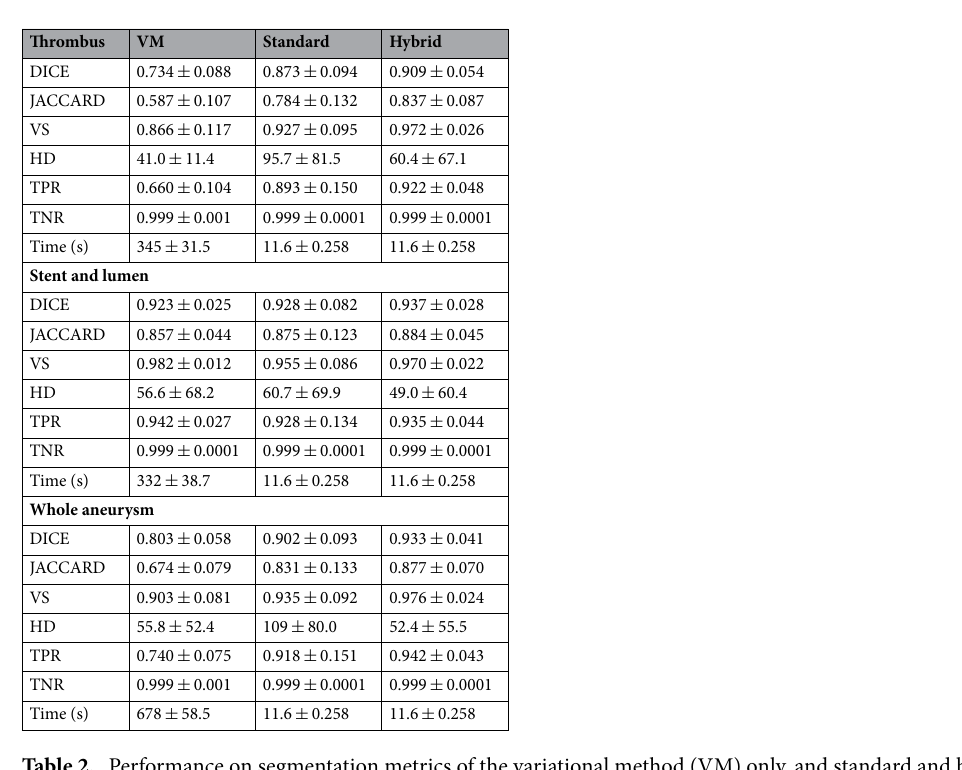
Table 2. Performance on segmentation metrics of the variational method (VM) only, and standard and hybrid pipeline in aneurysm segmentation. Units given as mean ± standard